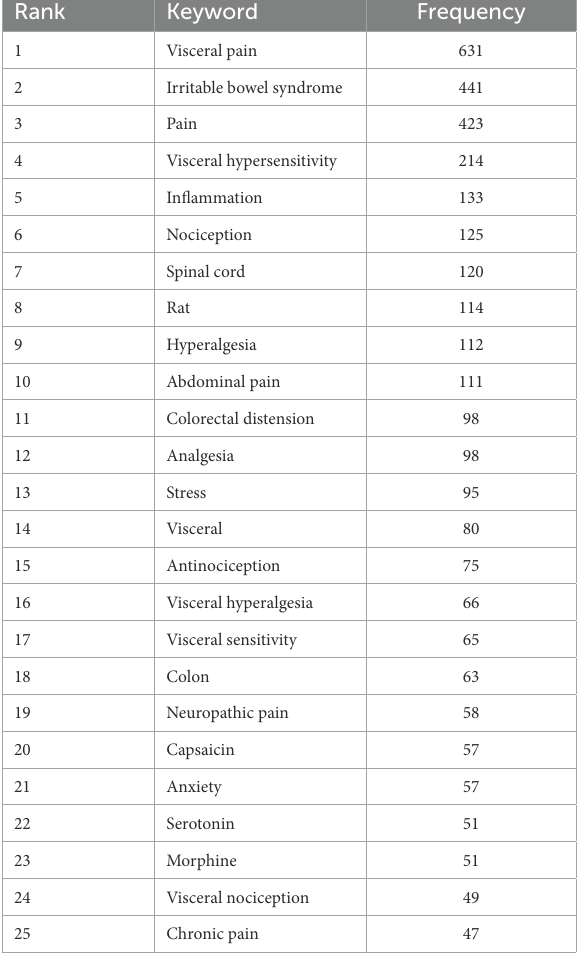
TABLE 6 The top 25 keywords related to visceral